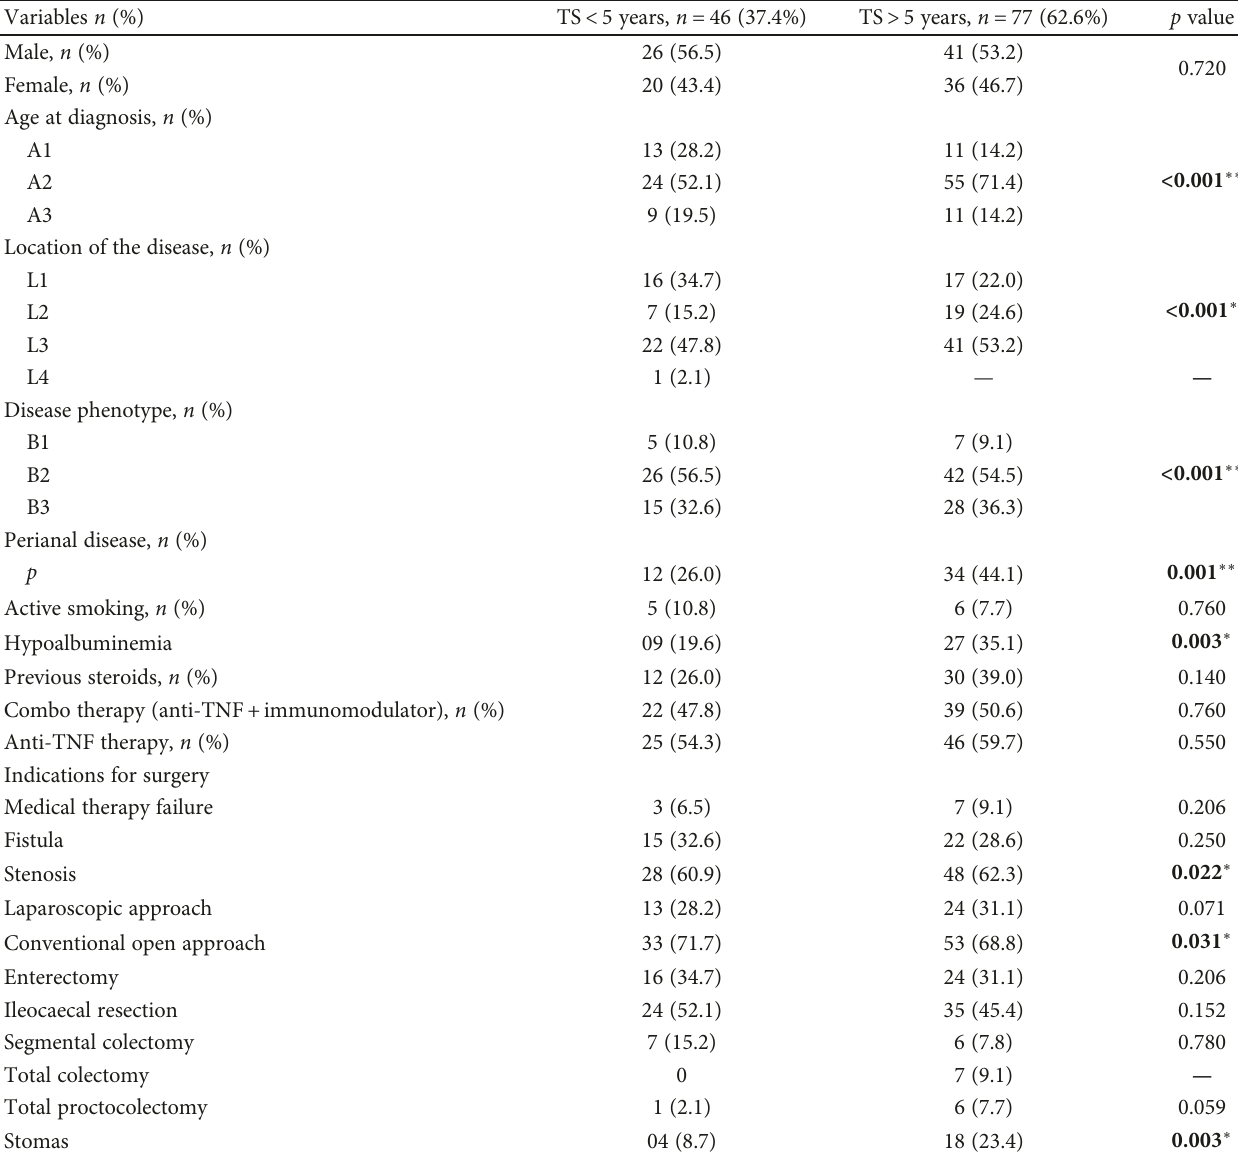
Table 1: Baseline characteristics and type of surgery performed in the two groups strati fi ed by TS ( < or > 5 years of